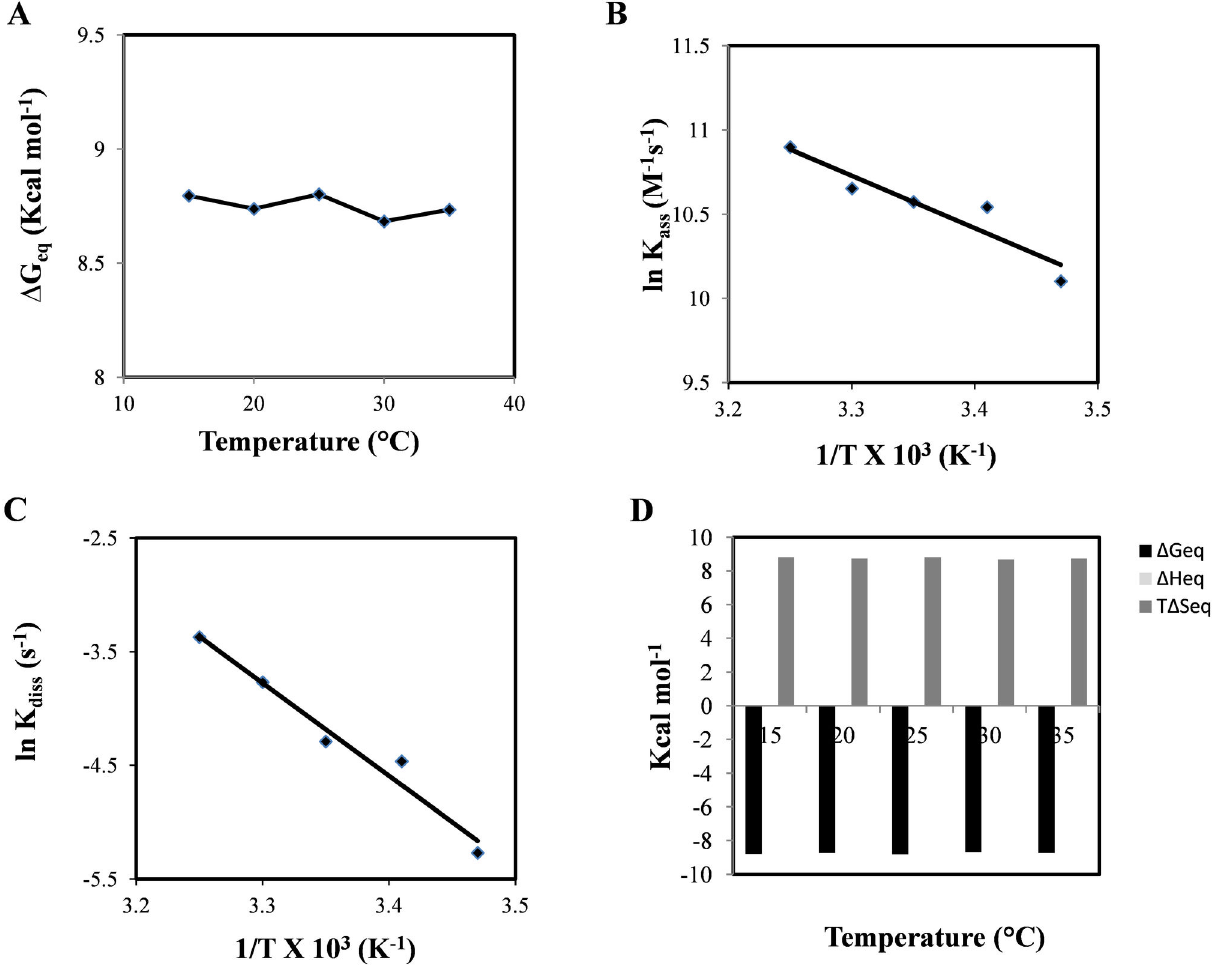
Figure 4. SPR based thermodynamics of antigen – antibody interaction. A. Changes in Gibbs free energy of binding (∆G) at different temperatures (15°C - 35°C). B. Arrhenius plot for association. C. Arrhenius plot for dissociation. D. Individual contributions of enthalpy (∆H) and entropy (T∆S) to equilibrium free energy of binding (∆G), at temperatures ranging from 15°C to 35°C. Bars corresponding to ∆H are not visible in the figure because of their negligible